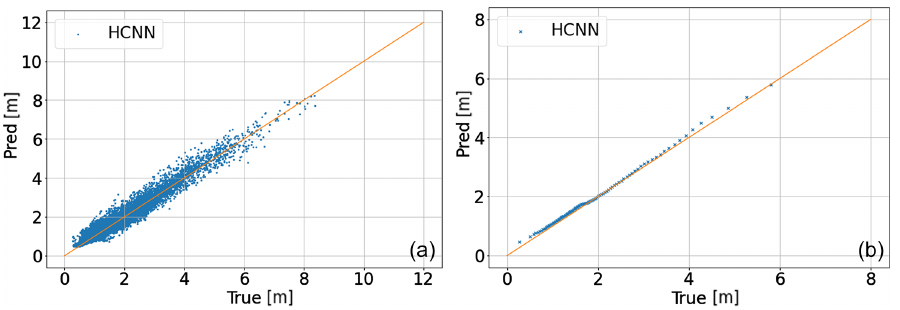
Figure 7. (a) Scatterplot. (b) Quantile–Quantile plot. Table 1. Proportion and mean of target H s of each sea state during the test period selected for node no. 7818. Sea state Unimodal Multimodal Wind sea wave Swell Wind sea wave + 1 swell 2 swells Wind sea wave + 2 swells At least 3 swells Proportion 10.26% 38.02% 21.19% 11.16% 10.16% 6.83% Mean H s 3.76m 2.15m 1.80m 1.45m 1.17m